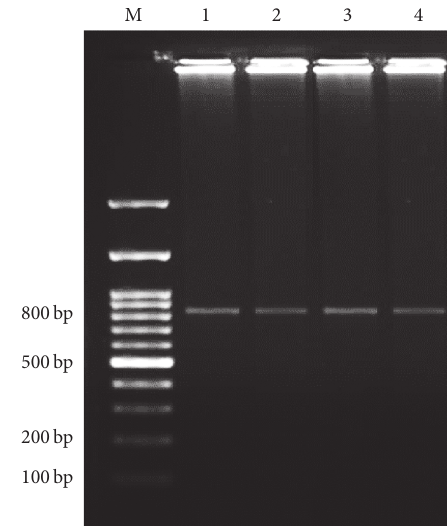
Figure 1: Secondary stage of nested-PCR findings on agarose gel. Lane M, DNA size marker. Lane 1, positive control for Cryptosporid- ium . Lanes 2–4, positive Cryptosporidium samples